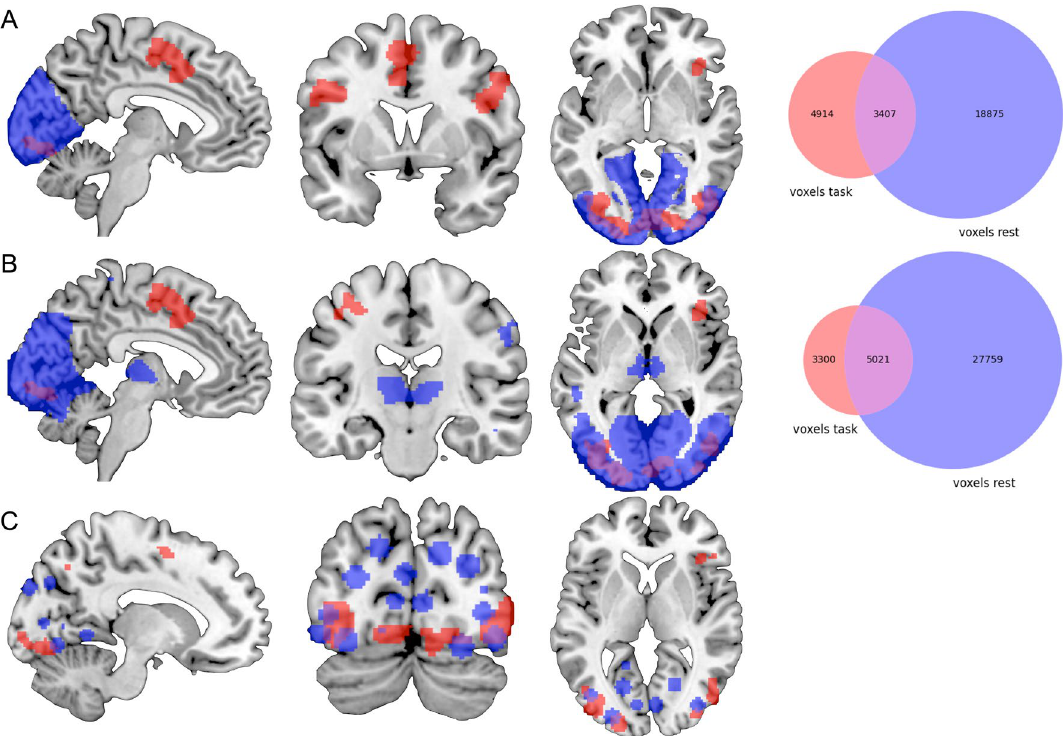
Figure 6. Overlap between the task-based (red) and resting-state-derived (blue) visual networks by ( A ) Yeo et al. 28 , ( B ) Smith et al. 17 , and ( C ) Power et al. 29 . For Power et al.’s graph nodes spheres of 6 mm were added for illustrative purposes. The Venn diagrams on the right illustrate the number of voxels either network as well as the overlap in between these networks comprises. Brain networks were rendered on the individual anatomical template (“ch2better”) provided with MRIcron 25 . Venn diagrams were created using the Python package Matplotlib-venn.